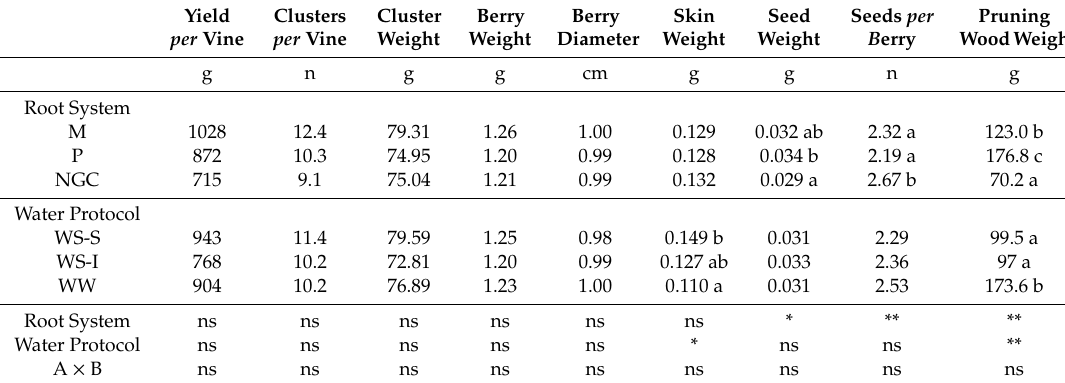
Table 1. Production parameters, berry characteristics, and pruning wood weight of Pinot noir vines grafted on Mgt 101-14 (M), 1103 Paulsen (P), and not grafted vines (NGC), treated with three irrigations protocols (WS-S, WS-I, and WW). Data were subjected to two-way ANOVA: *, **, ns indicate significant di ff erences at P < 0.05, 0.01, or not significant. Within root system and water protocol, di ff erent letters indicate significant di ff erences (LSD test, P < 0.05).